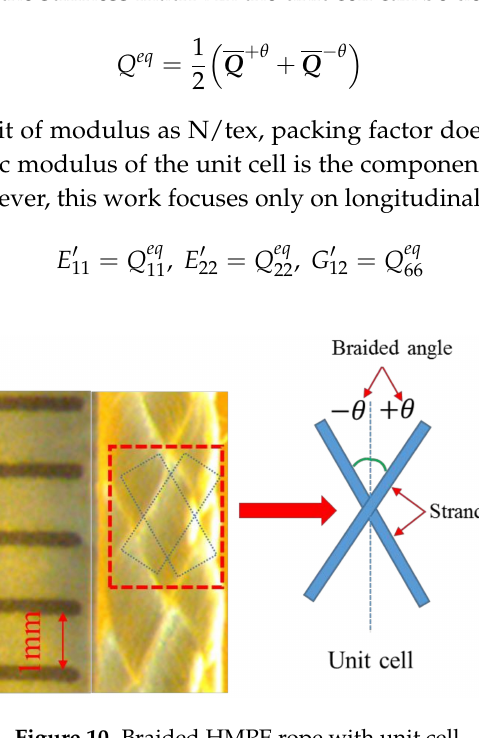
Figure 10. Braided HMPE rope with unit